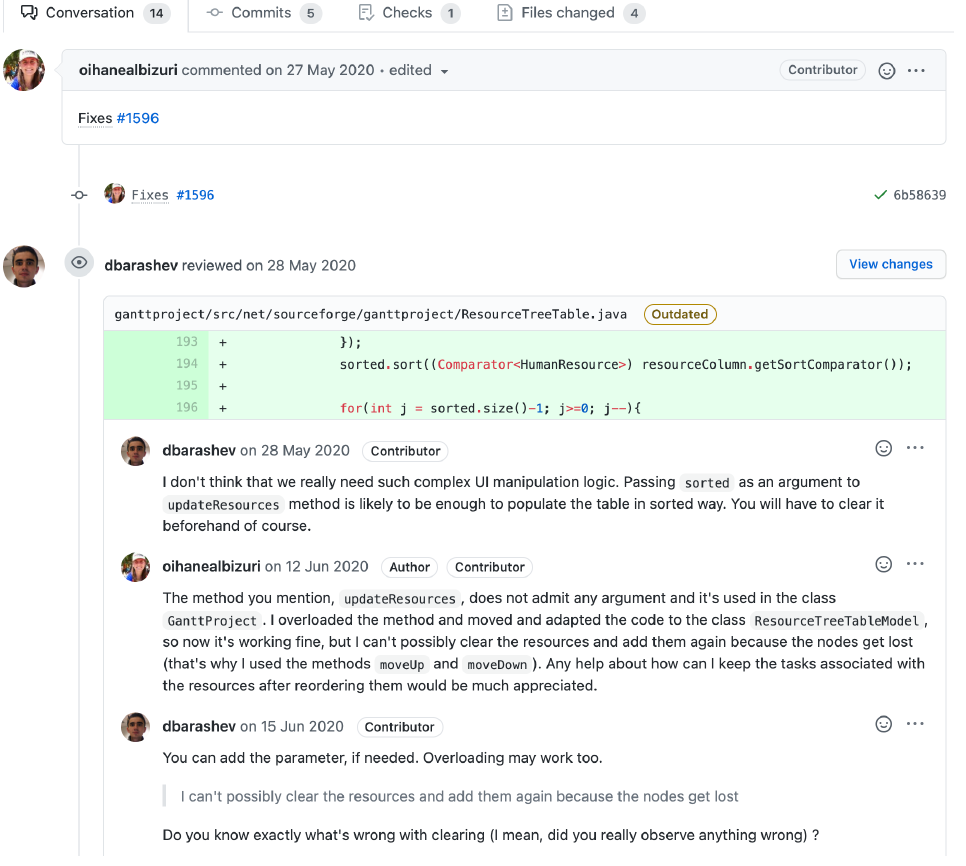
Figure 1. The quality control of consolidated open source projects includes a review of the code contributions. For the students, this was the first time that an external developer reviewed their source code in